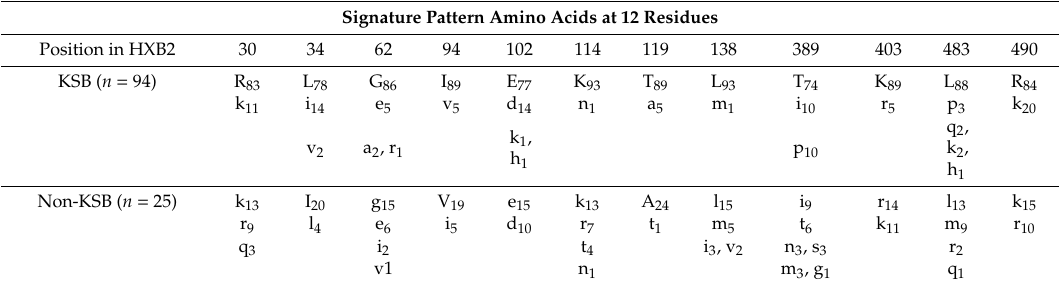
Table 2. Signature pattern residues in the Gag proteins of 110 infected patients. Signature Pattern Amino Acids at 12